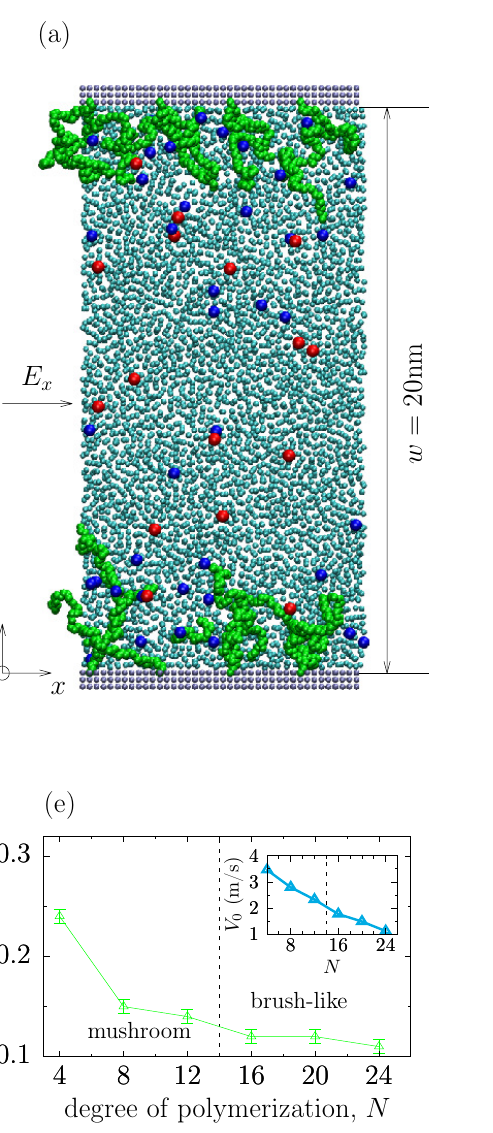
Figure 1. Polymer coating screening the electrokinetic flow in a slit. ( a ) Snapshot from molecular dynamics (MD) simulations. A homogeneous electric field E x is applied in the x direction to drive the electro-osmotic flow, which is screened by the polymeric coatings attached to the slit walls. The ions are depicted by red and blue colors, and the solvent is turquoise; ( b , c ) Averaged ion density ( b ), and polymer bead and solvent densities ( c ), across the slit from MD simulations; ( d ) Average solvent velocity across the slit from MD simulations and from the continuous Navier-Stokes-Brinkmann (NSB) model. The inset shows the solvent velocity in the middle of the slit as a function of the applied field. In ( a – d ), the degree of polymerization N = 14 so the polymers have 3 N + 2 = 44 free beads (see Section 2). The polymers are placed on a square lattice with the lattice constant a = 2.5 nm on both slit walls. The slit width is w = 20 nm. Effective hydrodynamic radius of the polymer bead in the NSB model a bead 0.019 nm; ( e ) The effective hydrodynamic radius of the polymer bead as a function of the ≈ degree of polymerization N ; a bead is normalized to the Lennard-Jones radius of the bead a 0 = 0.156 nm. The inset shows the mid-plane solvent velocity versus N